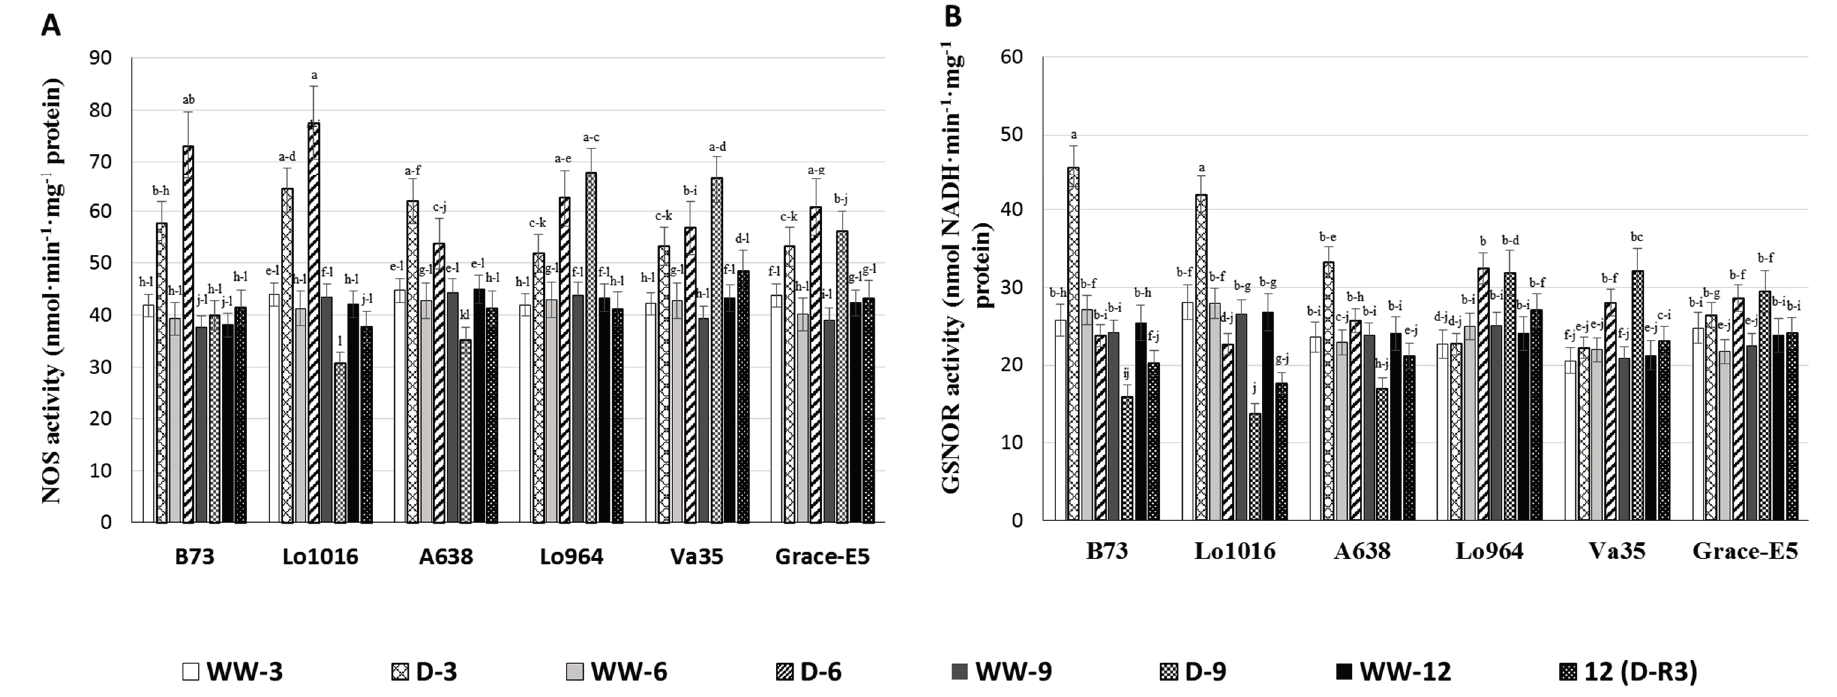
Figure 6. The NOS and GSNOR activities in maize seedling leaves under well-watered (WW) and drought (D) conditions. Nitrosative stress-related enzyme activities were measured in sensitive and tolerant genotypes over drought stress and recovery including NOS ( A ); and GSNOR ( B ). Different letters indicate significant differences ( p < 0.05) based on Tukey’s test between control and treatments and between different treatment times. Data represent the mean ± SD of three or more